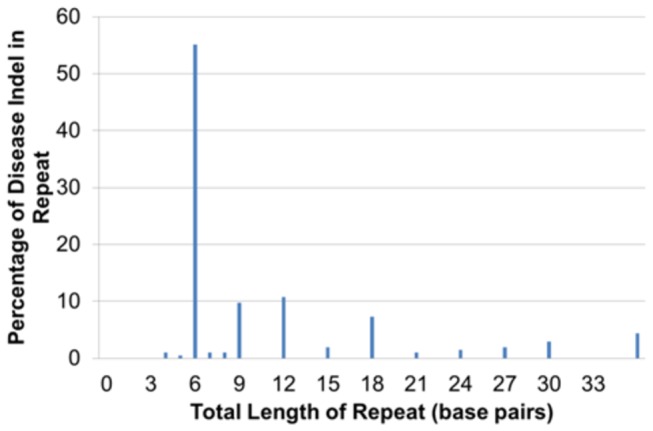
Repeat length distribution for disease indels in small exact repeat regions.On the x-axis is the total length of the repeat, which is the product of the period size of the repeat and the number of copies of the repeat.